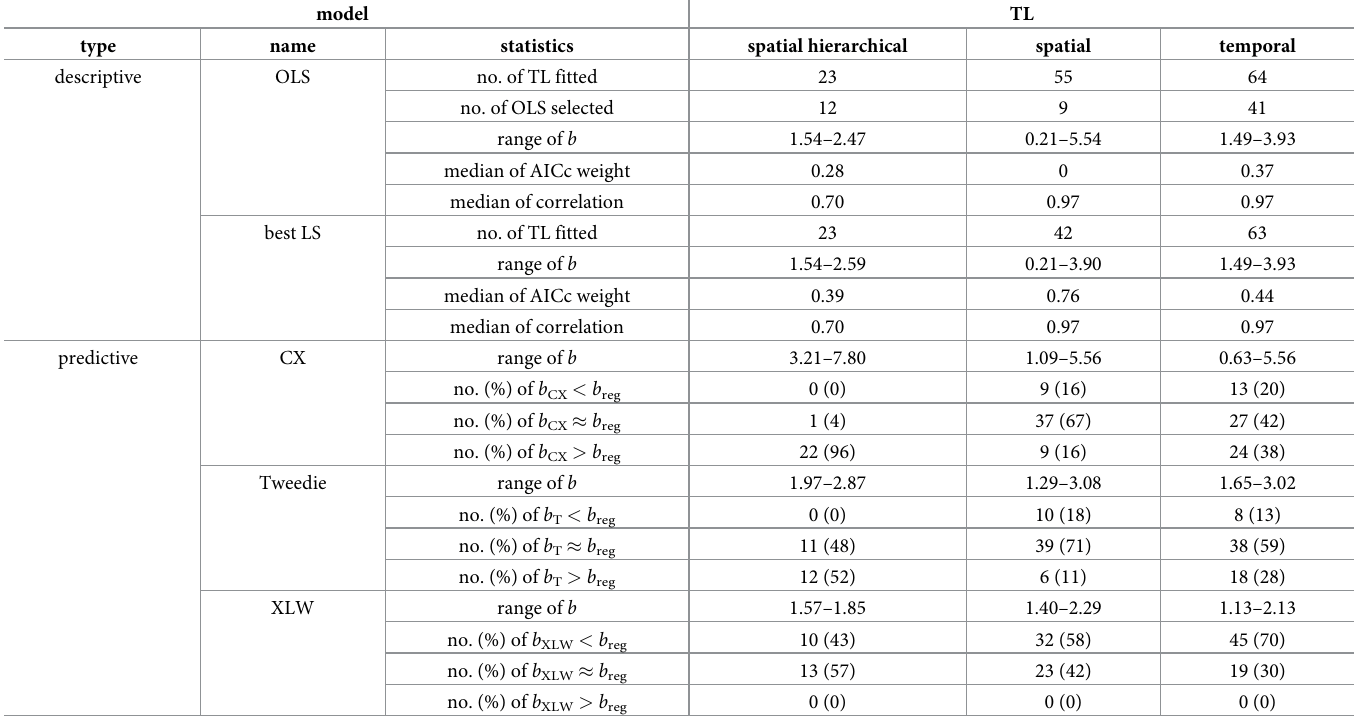
Table 1. Statistical models of TL and their summary statistics. The two descriptive models of TL are OLS (ordinary least-squares) and best LS (which is the OLS or GLS with the smallest AICc). The three predictive models of TL are the CX (Cohen-Xu) model, the Tweedie model, and the XLW (Xiao-Locey-White) models. 13 of the best LS models for the spatial TL and one of the best LS models for the temporal TL are GLS models that did not yield parameter estimates of TL due to failed convergence (for rea- sons not understood), resulting in respectively 42 (55–13) and 63 (64–1) best LS models. For each predictive model, the corresponding prediction of b is significantly less than ( < ) b reg if the 95% interval estimate of the corresponding slope difference (from bootstrap samples) is less than zero, not significantly different from ( � ) b reg if the 95% interval estimate contains zero, and significantly greater than ( > ) b reg if the 95% interval estimate is greater than